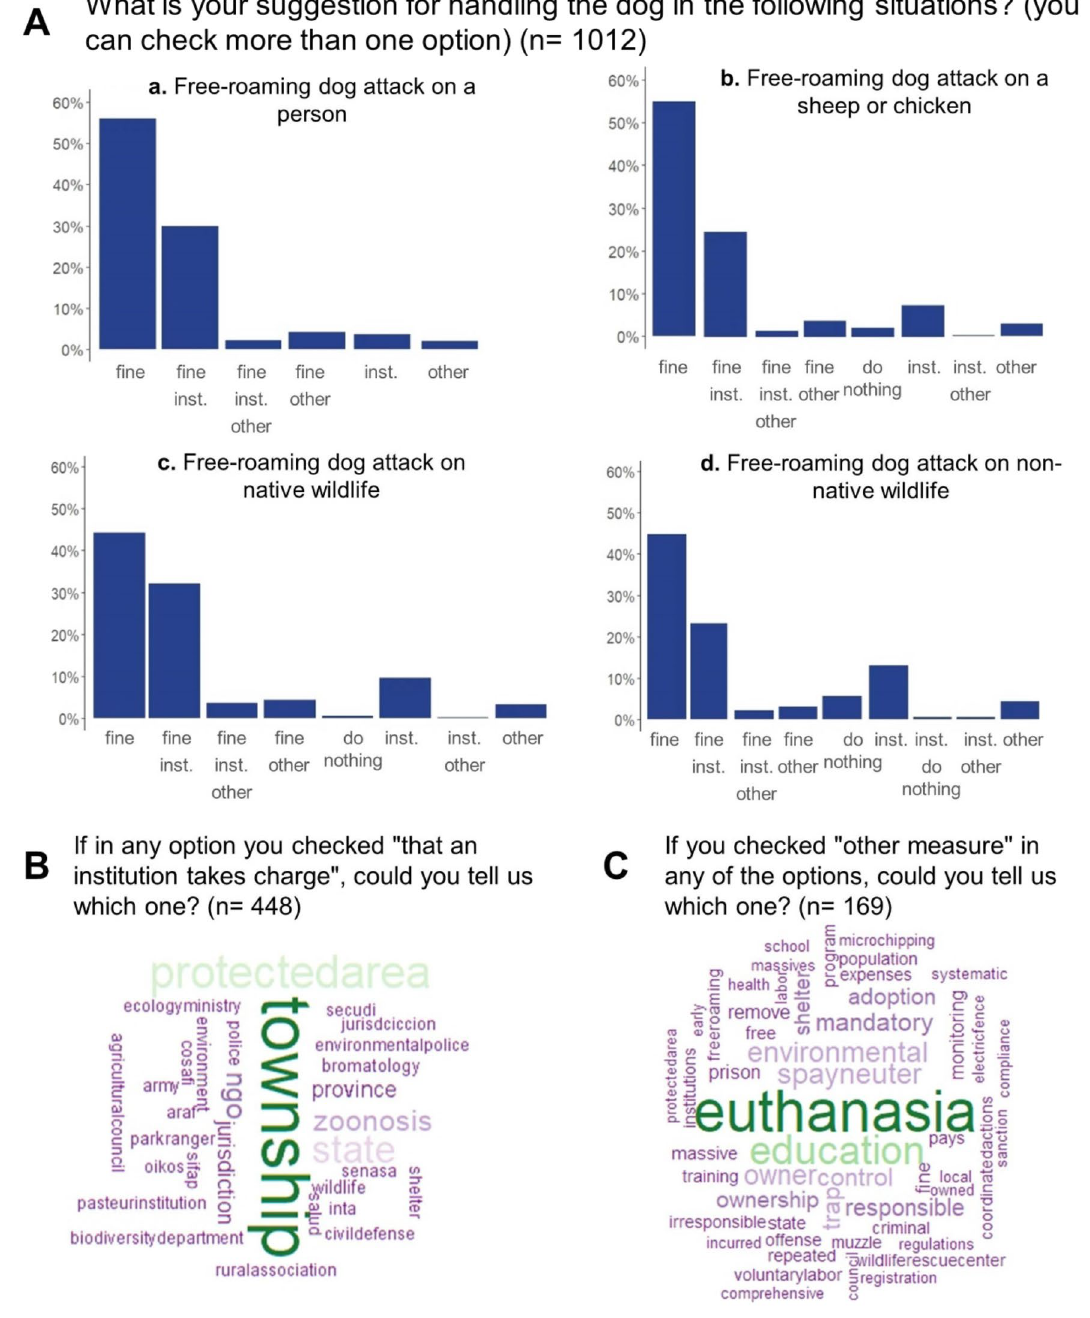
Figure 4. Agreement with proposed measures in cases of hypothetical dog aggression events ( A ), institutions expected to act in response to these events ( B ), and other measures proposed ( C ); the larger the words the more respondents who proposed this